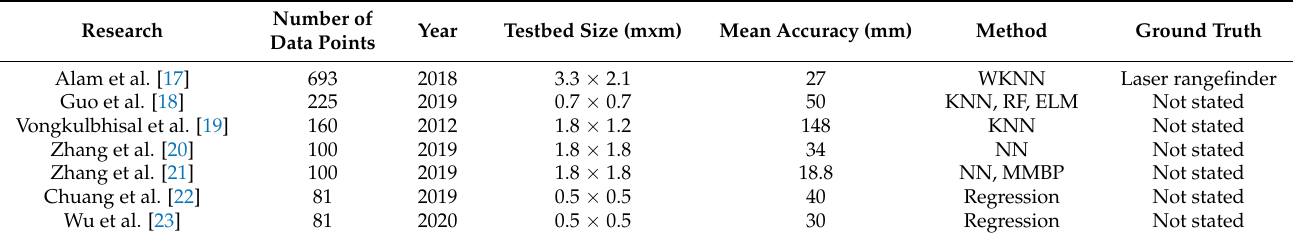
Table 1. VLP articles listed by size of experimental data set. Most articles use a limited number of data points and do not describe how ground truth was